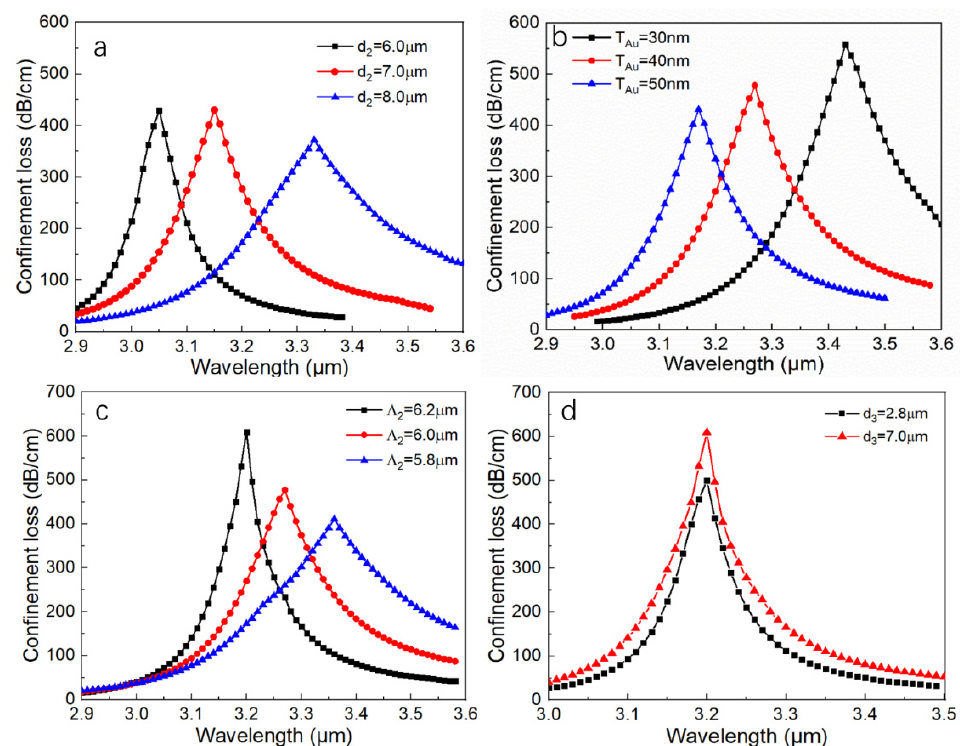
Figure 4. Loss spectra for ( a ) di ff erent diameters of central holes d 2 with d 1 = 2.8 µ m, d 3 = 7.0 µ m, Λ = Λ = 6.0 µ m, T = 50 nm, and n = 1.36; ( b ) thickness of gold layer T a 1 2 Au